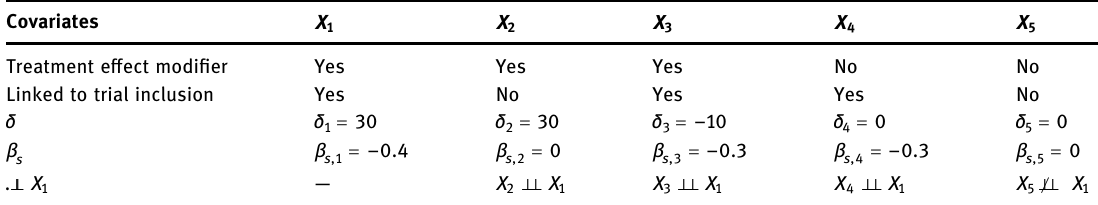
Table 3: Simulations parameters